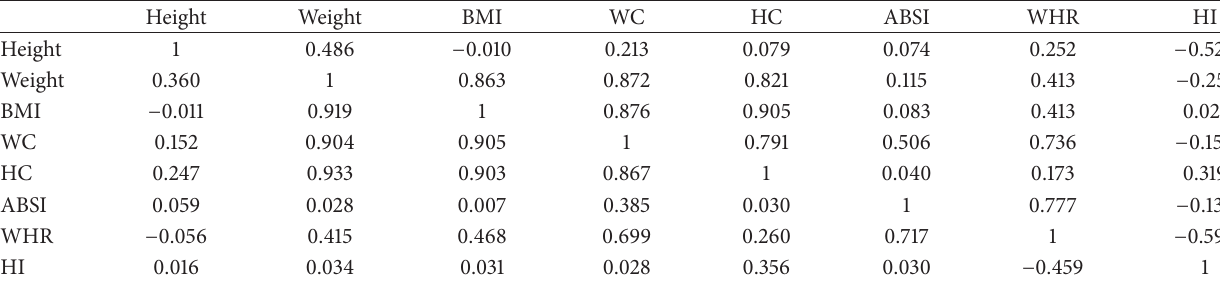
Table 1: Correlations of body measures in NHANES III.